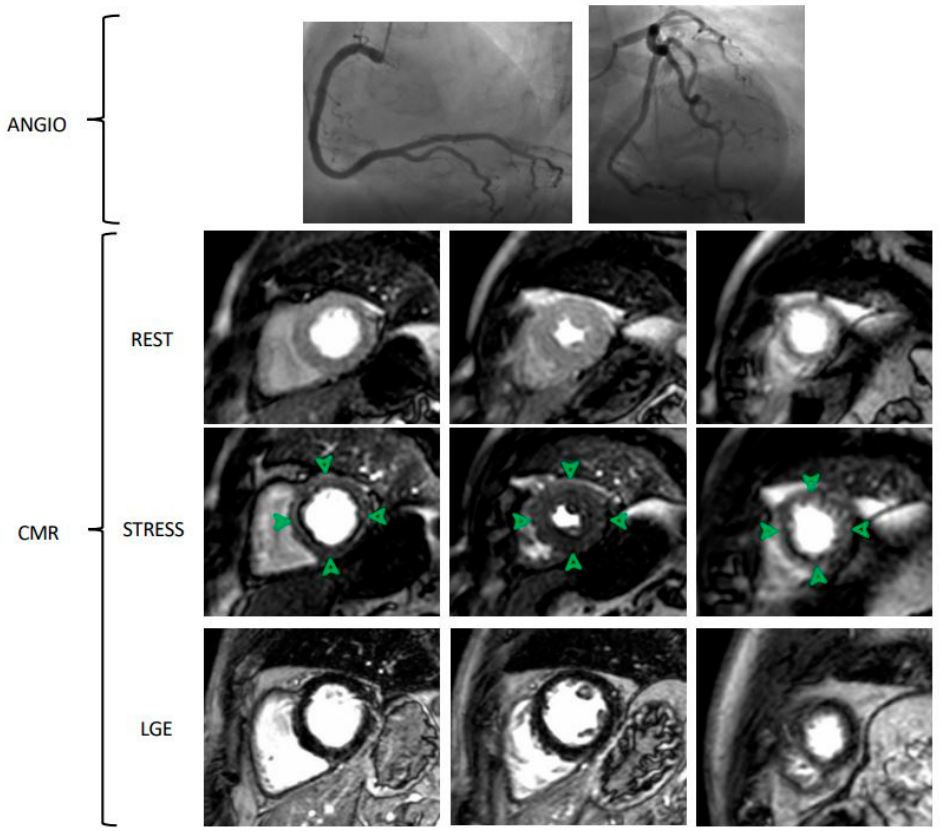
Figure 3. Cardiac Magnetic Resonance (CMR) evaluation of microvascular dysfunction in a patient with effort angina without obstructive coronary artery disease. Invasive coronary angiography shows epicardial coronary artery without obstructive disease. CMR sequences show three ventricular slices (basal, mid-ventricular, apical slices) during rest, stress and late gadolinium enhancement (LGE) protocols. Stress CMR is performed with adenosine administration (140 mcg/Kg/min for 3–6 min). Comparing rest and stress CMR sequences, there is a severe and diffuse hypoperfusion in the stress images, showed by a widely hypointense myocardium (green arrows): this pattern is consistent with microvascular dysfunction. LGE images show no myocardial fibrosis. CMR Sequences: Saturation recovery gradient echo pulse sequences for rest and stress images; Inversion recovery gradient echo sequences for LGE images.